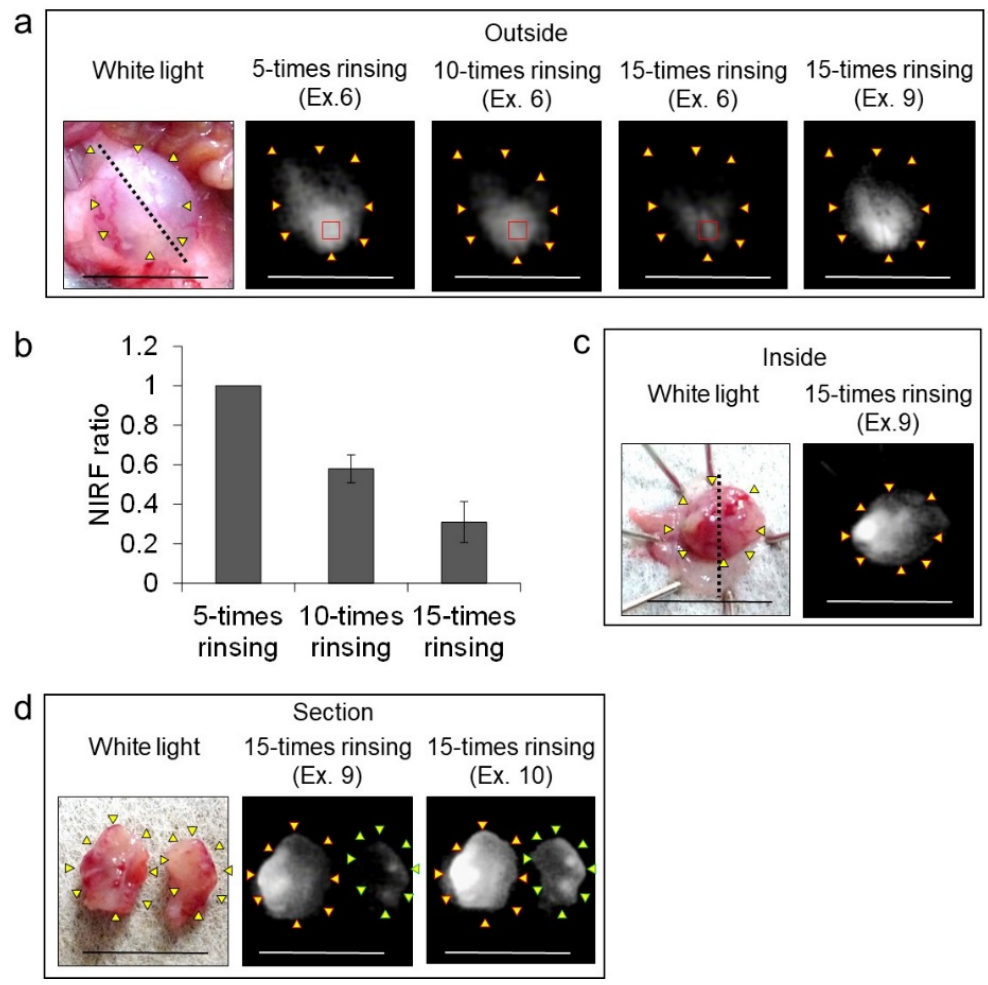
Figure 9. Effect of rinsing with saline on near-infrared fluorescence (NIRF) imaging of MB49 bladder cancer in three mice after intravesical administration of ASP5354. ( a ) Representative images of the three bladders. ASP5354 (2.4 μ M) was injected in cancerous bladder, and 5 min after that, rinsed with saline 5, 10, or 15 times, filled up with saline, and NIRF imaging was performed from outside the bladder. Yellow arrows show points of boundary between NIRF and non-NIRF in photo for 5-times rinsing. ( b ) NIRF intensity ratio of the region of interest shown in red squares in photos ( a ). NIRF intensities are presented as means ± standard deviation ( n = 3 bladders). ( c ) After the imaging from outside the bladder shown in photo ( a ), the bladder was picked out and opened along the black dotted line. NIRF in the obtained bladder inner layer was imaged. Yellow arrows show points of boundary between NIRF and non-NIRF. ( d ) The bladder inner layer shown in photo ( c ) was sectioned and NIRF image was obtained. Yellow and green arrows show points of boundary between NIRF and non-NIRF. Excitation levels (Ex.) are shown above photos. NIRF is displayed in white. Scale bar represents 10 mm.